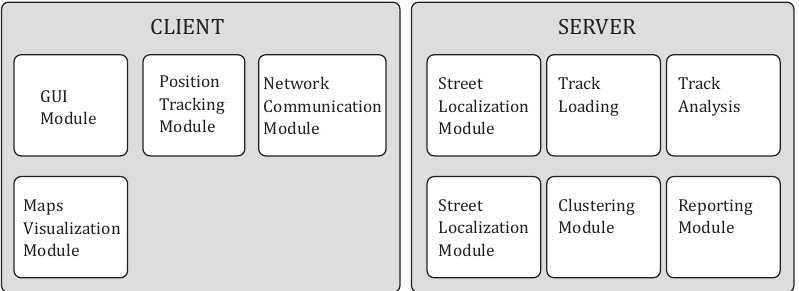
Figure 2. The composition of the client and server